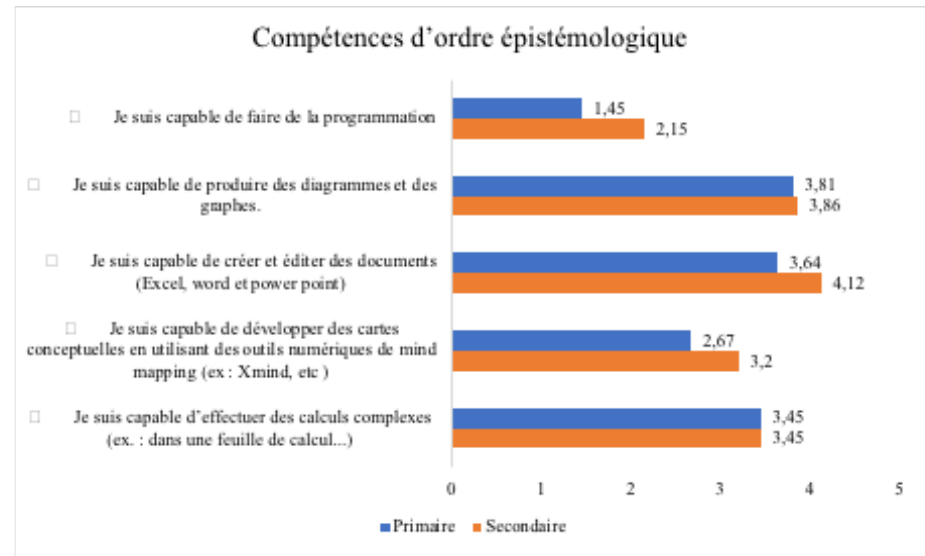
Fig. 7. Les compétences d’ordre épistémologique déclarées maitrisées à l’issu de la formation au